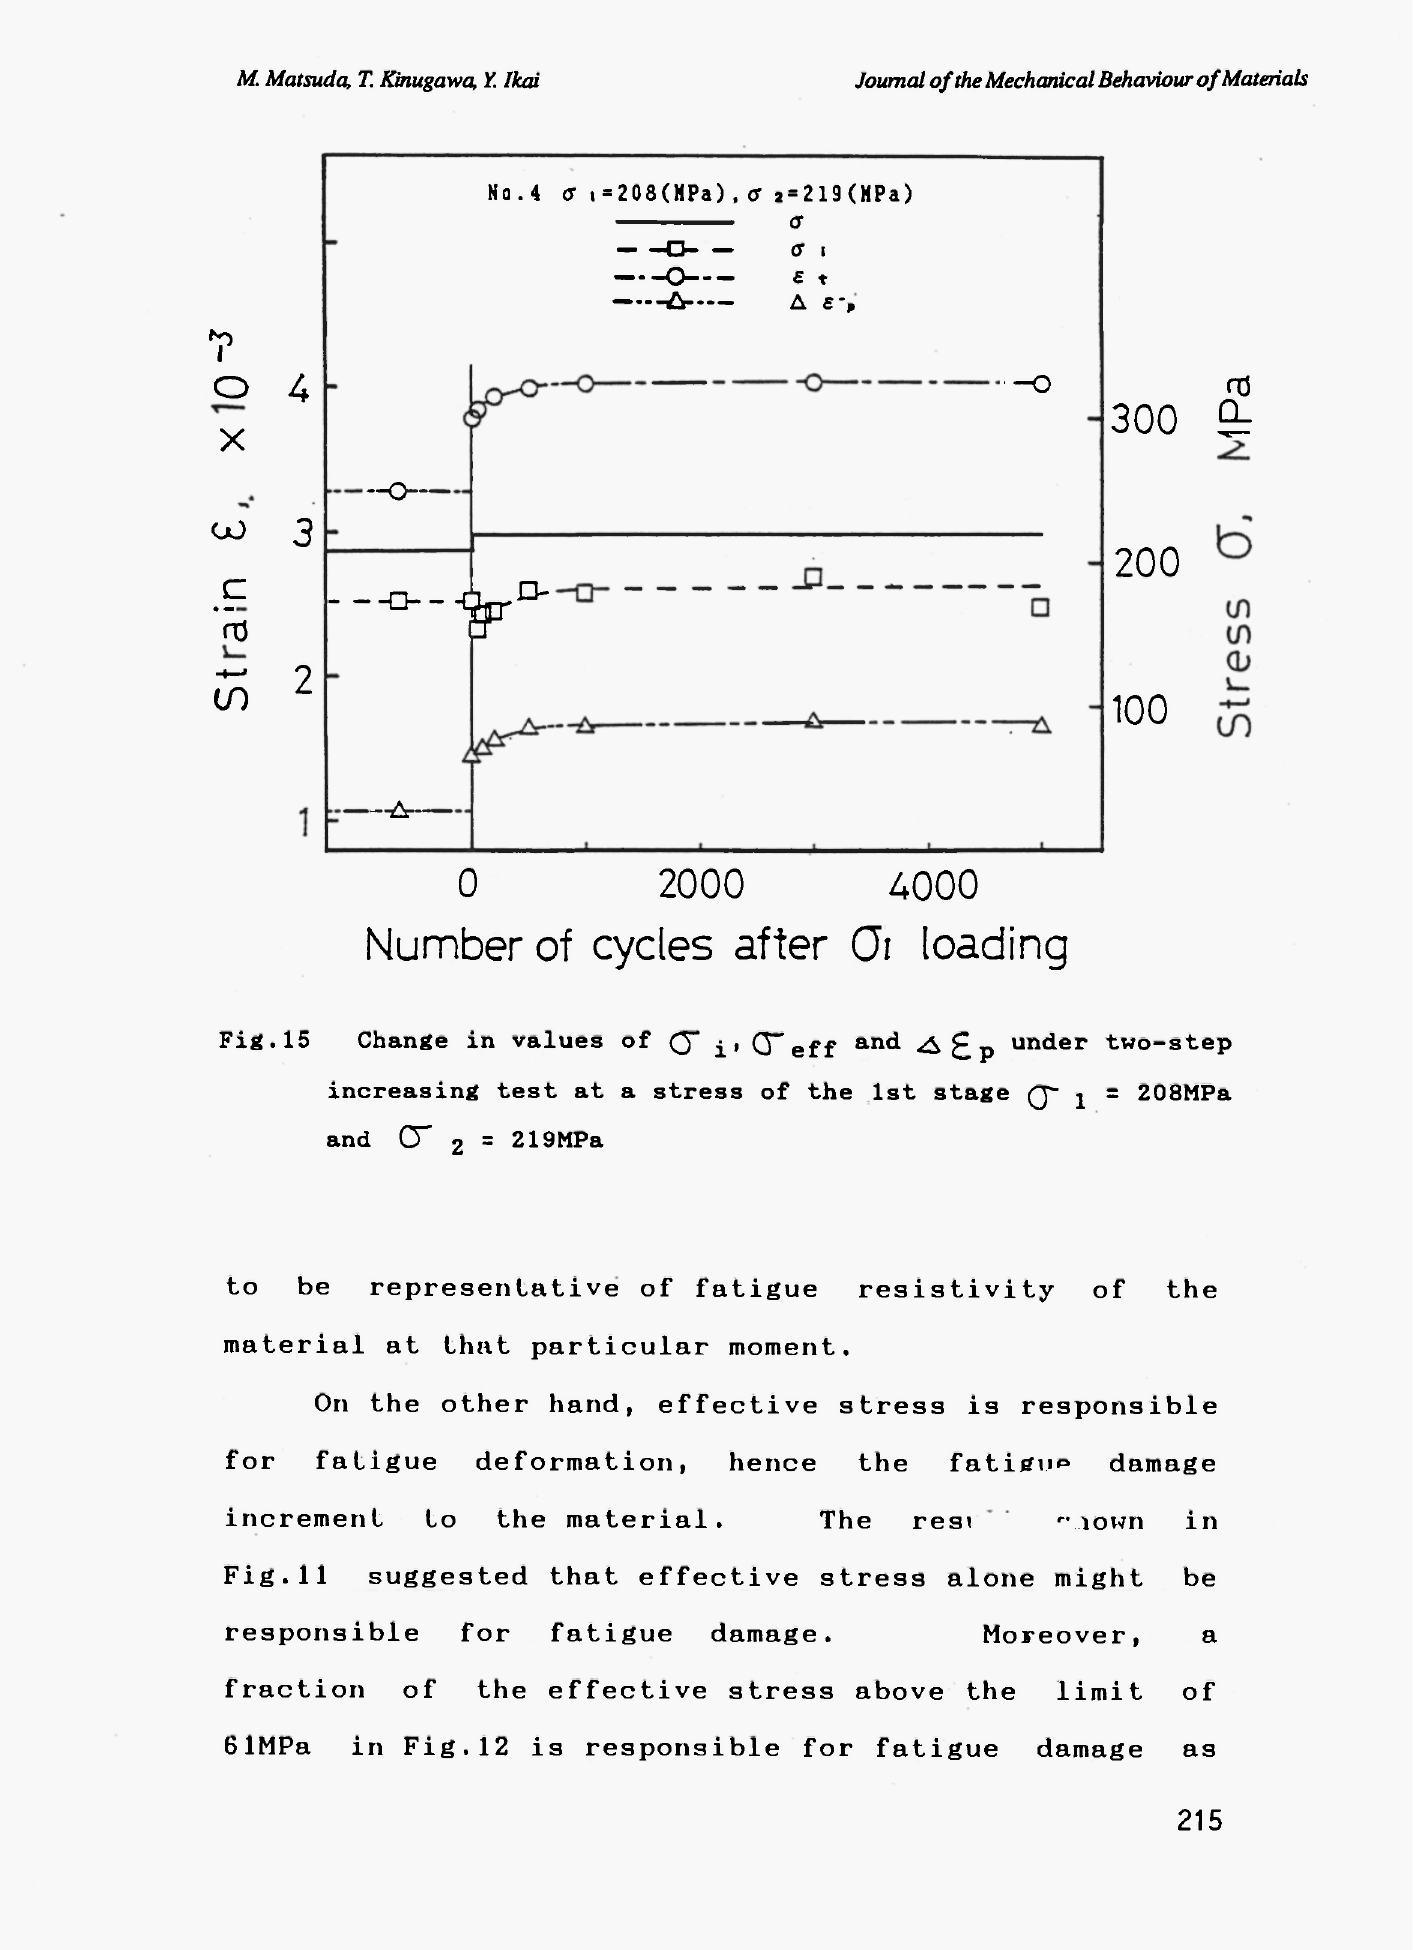
Fig. 15 Change in values of (J ± , G ~ e ff and £ p under two-step increasing test at a stress of the 1st stage (J~ j = 208MPa and CT 2 =